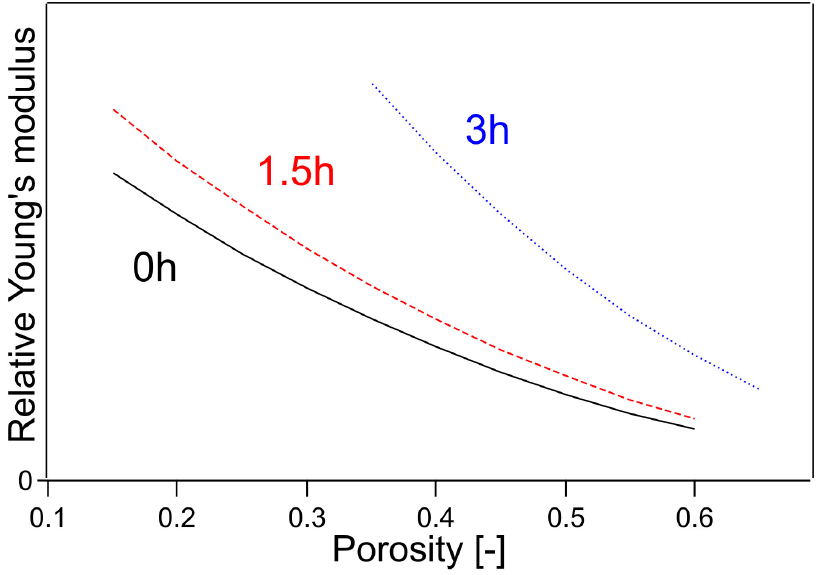
Figure 6. Young’s modulus fitted by Equations (14)–(16). The numbers in the figure indicate the heating time of the sample.